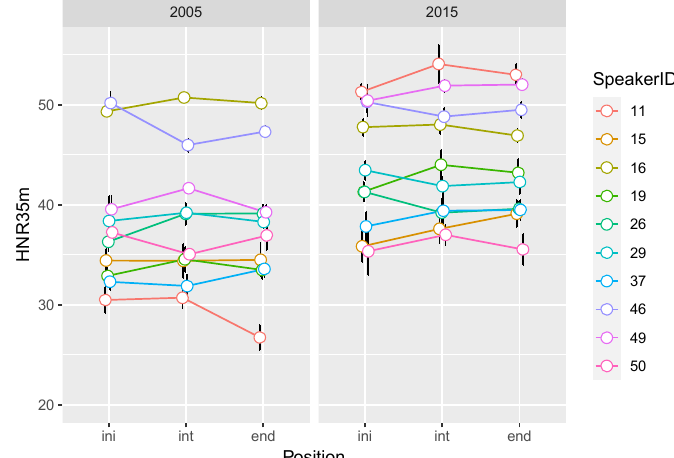
Figure A6. Speaker-specific data for H2KH5K.